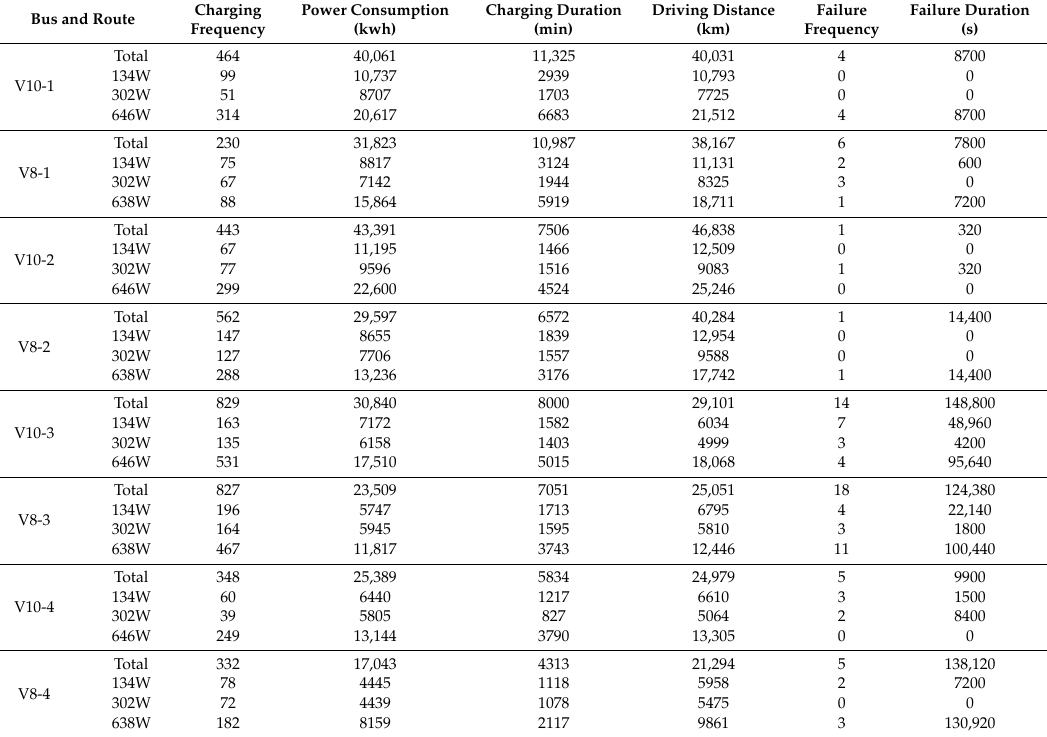
Table 5. Data Summary Table.